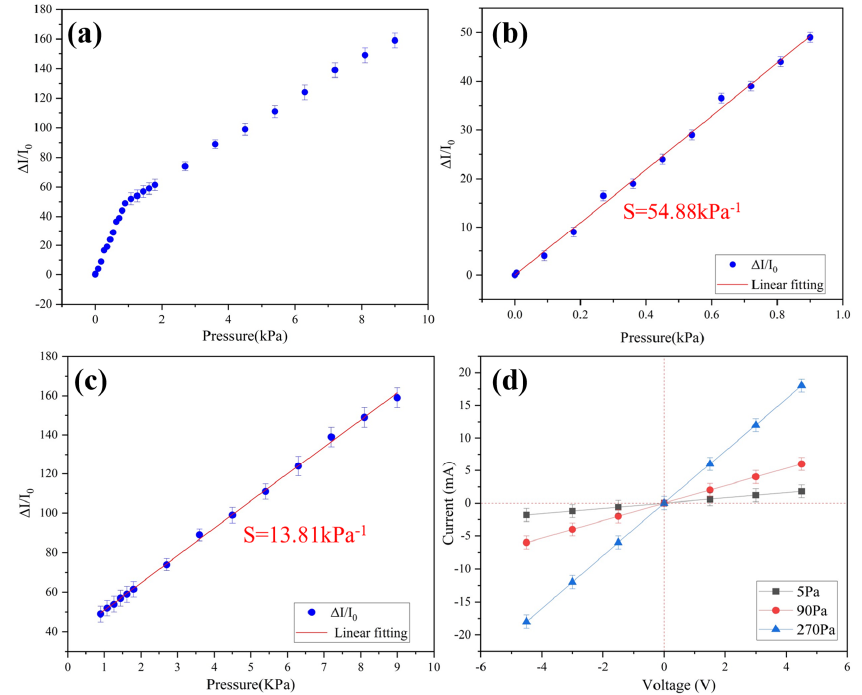
Figure 3. ( a ) Relative changes in current corresponding to different applied pressures; ( b ) sensitivity in the range of 0–0.9 kPa; ( c ) sensitivity in the range of 0.9–9 kPa; ( d ) I-V curves under different pressures. Table 2. Comparison of pressure sensitivity with previously reported pressure sensors (PDMS: pol- ydimethylsiloxane; OFET: organic field effect transistor; PVDF: polyvinylidene difluoride).